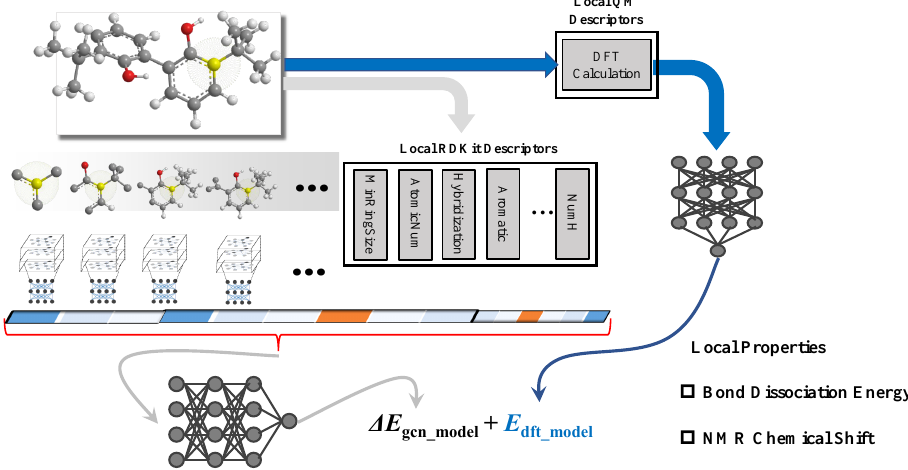
Figure 2. The he workflow of the proposed F-GCN, designed for inter-atomic and atomic property prediction with inclusion of assisting